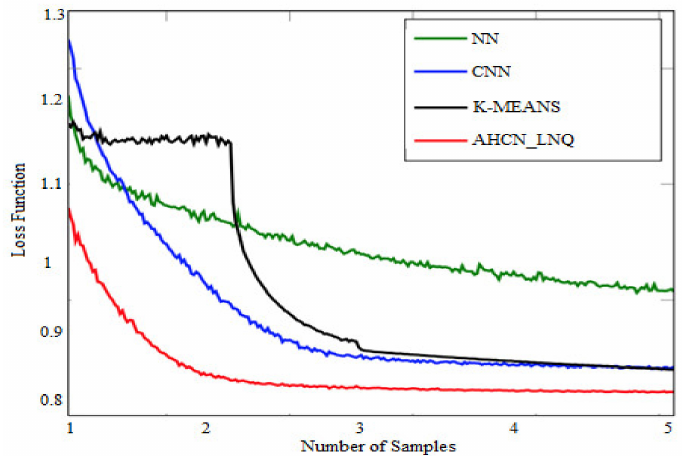
Figure 9. Loss function of training set.